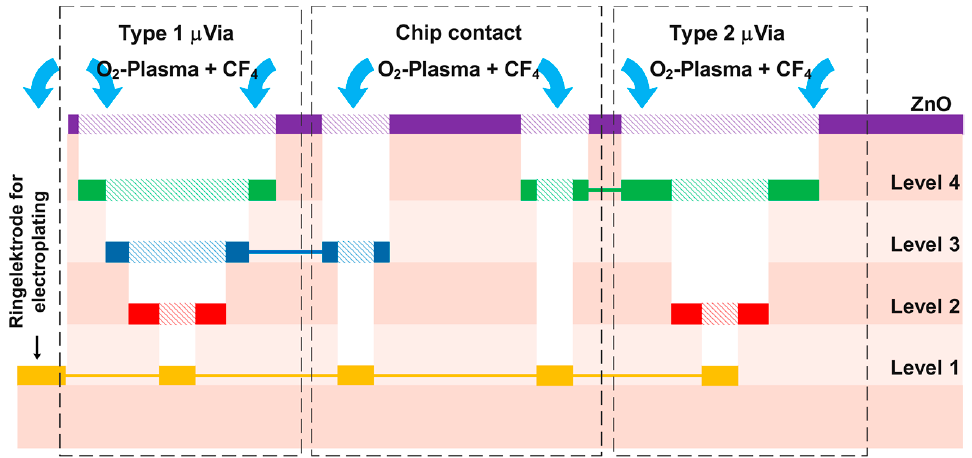
Figure 2. Schematic cross-sectional view of the via structure for connecting the individual layers. As a time saving alternative to the plasma etching, femtosecond laser ablation can be used to drill the micro-vias into the PI film. Since the metallization level 1 Au layer was very thin, the laser parameters had to be selected carefully to fully remove the PI of different thickness but not to damage the metal. In first tests with simplified micro-via test structures it was found that thin layers of unremoved PI were hard to avoid but with only 5 min of dry etching the gold surface could be perfectly cleaned. However, a micro-via design adaption would be required. Even with precise knowledge of the laser ablation parameters it was hard to predict the necessary process time for each via depth, which means each level needs separate